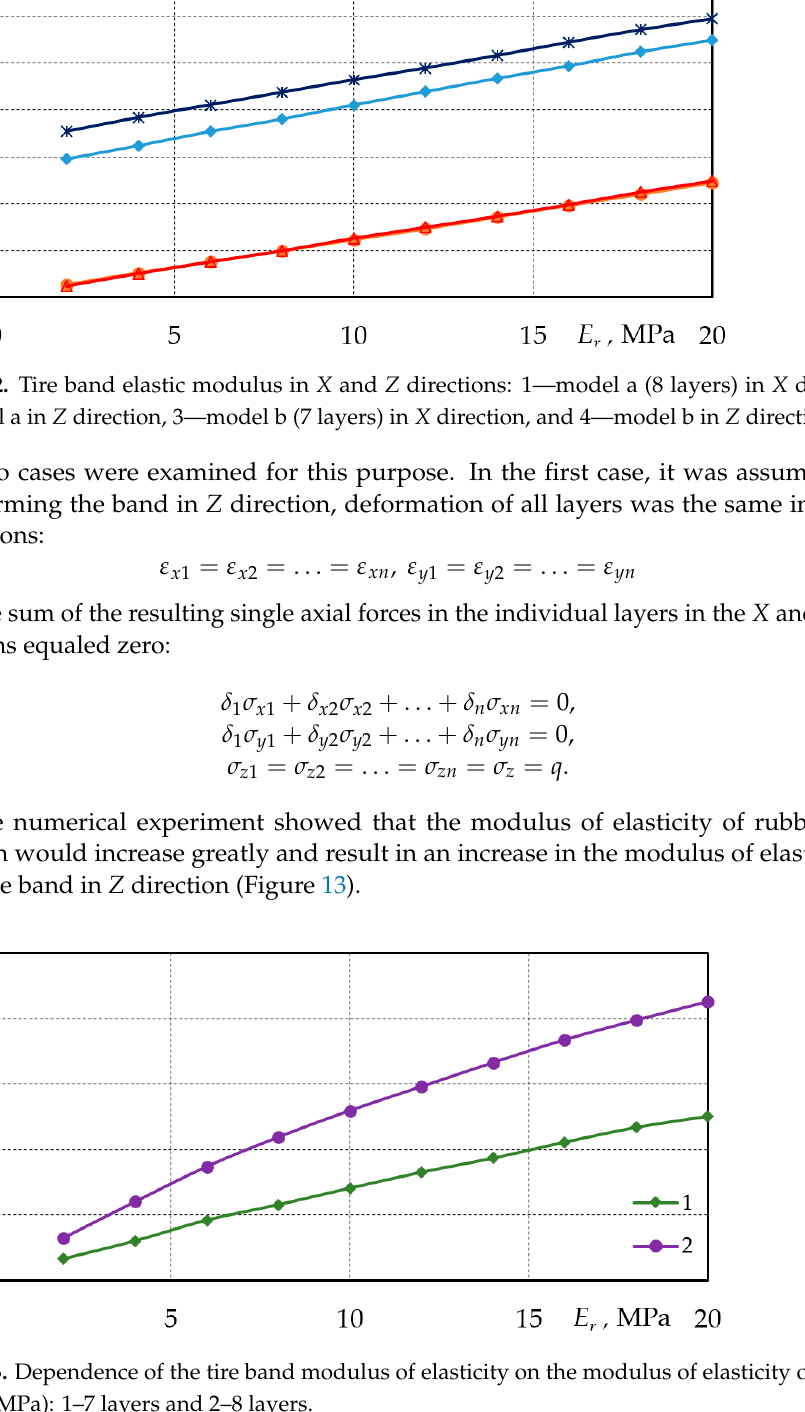
Figure 13. Dependence of the tire band modulus of elasticity on the modulus of elasticity of rubber ( σ z = 0.2 MPa): 1—7 layers and 2—8 layers. ( σ z = 0.2 MPa): 1–7 layers and 2–8